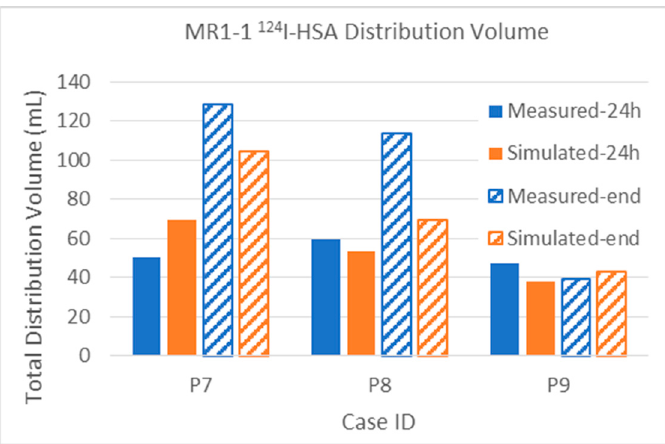
Figure 9. Comparison of measured and simulated 124 I-HSA distribution in MR1-1 patients. Total infusion rate (from four catheters) was 2 mL/h. Patients 7 and 9 were infused for the full 72 h; Patient 8 was stopped early after 54 h of infusion. Pharmaceutics 2020 , 12 , x FOR PEER REVIEW 18 of 37